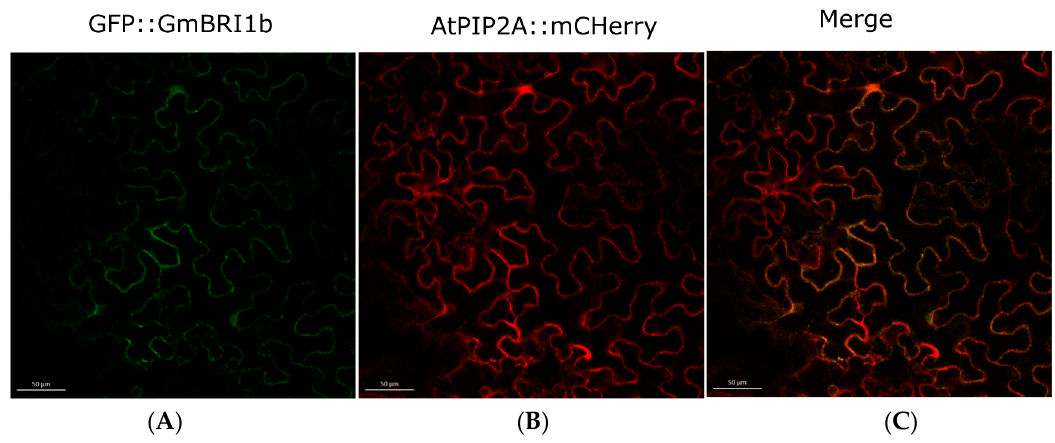
Figure 2. Subcellular localization of GmBRI1b. The subcellular localization was determined with the constructs GFP::GmBRI1b: ( A ) GFP::BRI1b; ( B ) AtPIP1A::mCherry; and ( C ) merged image. The GFP and mCherry signals were detected at 484 and 544 nm, respectively. Scale bar = 50 µm.